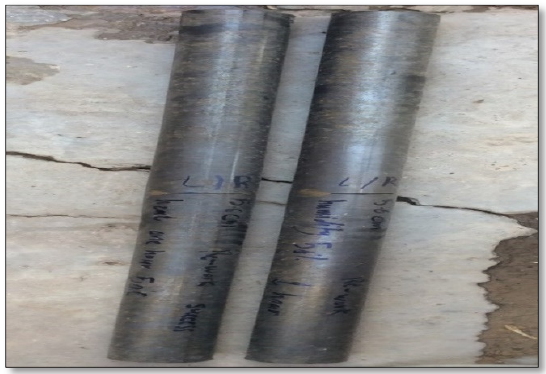
Fig.1. Two sample of length 100cm.